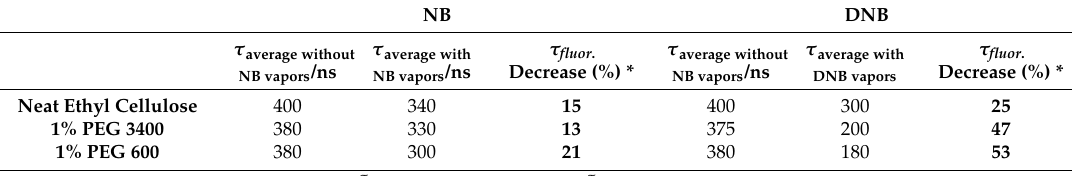
Table 2. Decay times of F8T2 in ethyl cellulose thin films with different plasticizers in the presence and in the absence of nitroaromatic vapors.